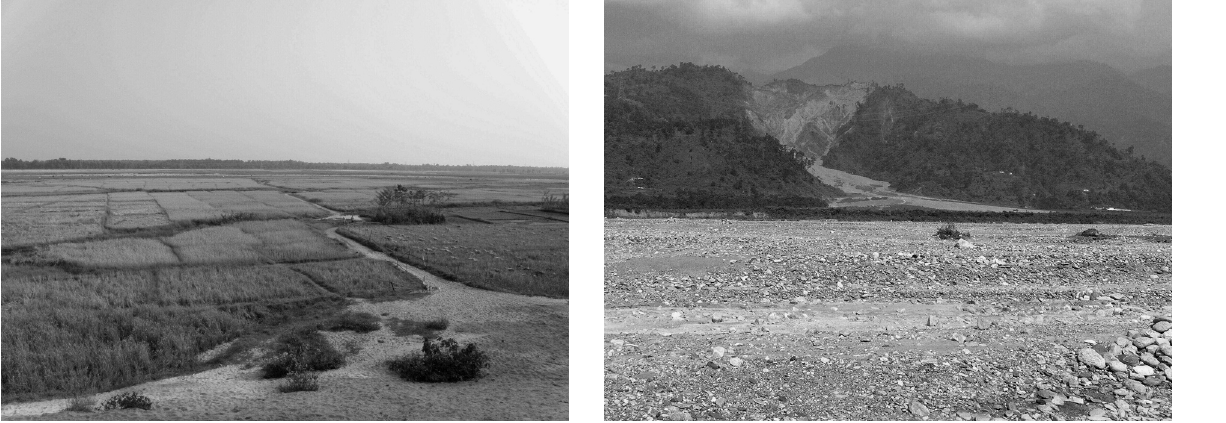
Fig. 2c. Paddy fields at the Gish floodplain. Fig. 2d. Landslide with fan supplying dry Gabur-Basra braided channel at the outlet from